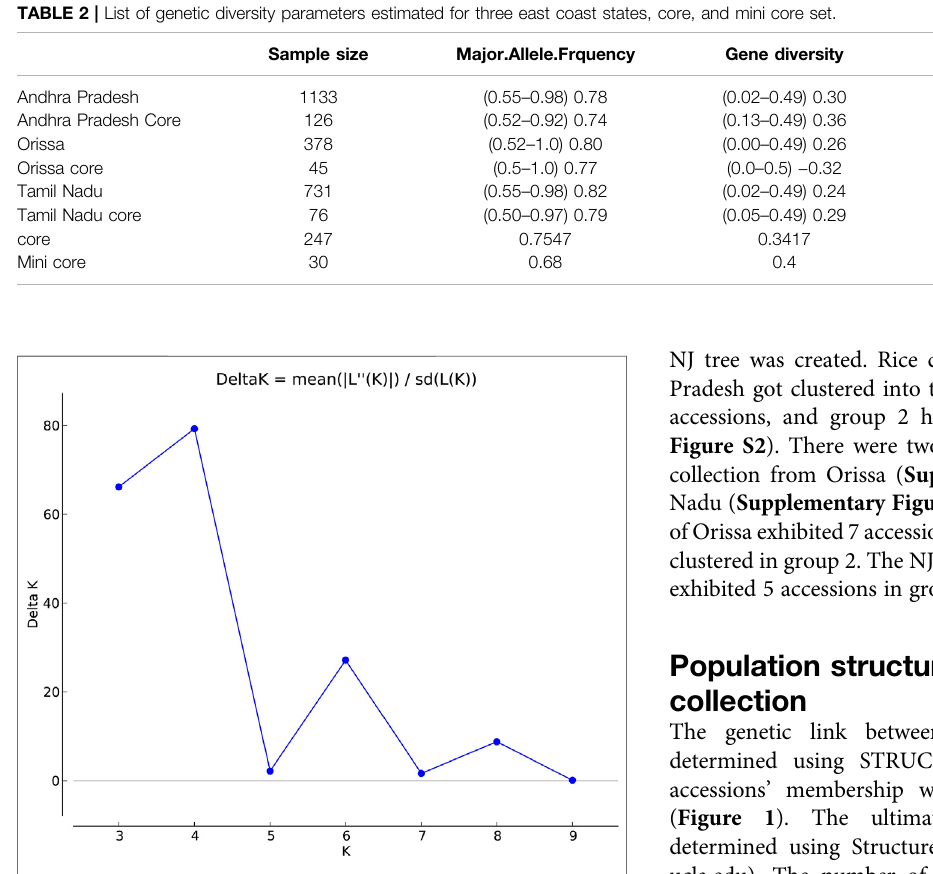
FIGURE1| EstimationofpopulationusingLnP(D)derived Δ kforkfrom2 to 10 of a total 2,242 east coast rice collection.